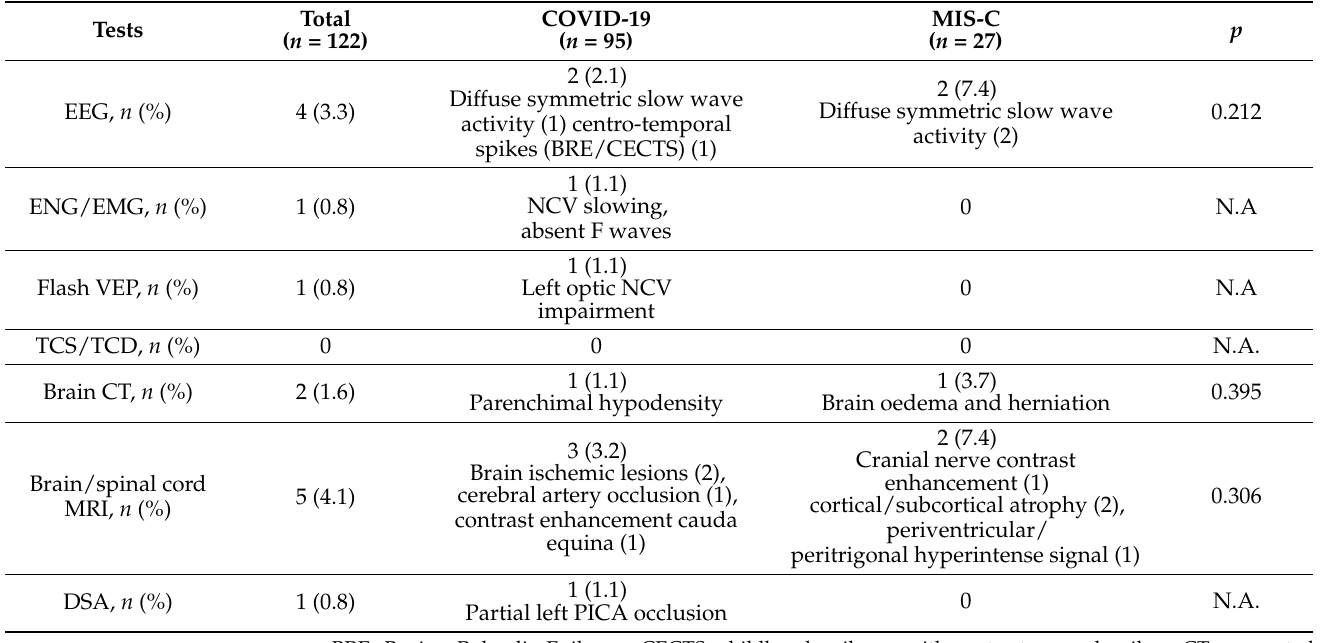
Table 3. Altered instrumental and radiological